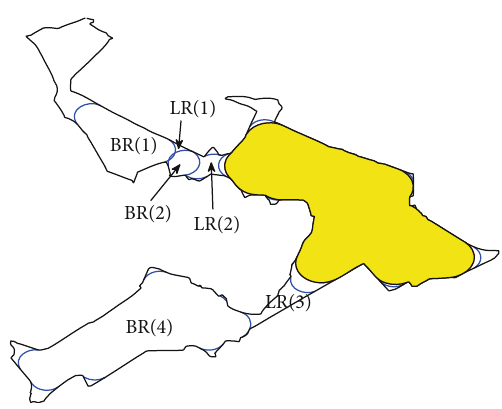
Figure 4: The favorable con fi guration of gas (yellow area) which invaded the pore space in the fi rst iteration step is shown along with the geometrically allowed oil-water AMs (blue) in a pore space extracted from Bentheim sandstone ( r r = 9 pixel lengths and θ gw